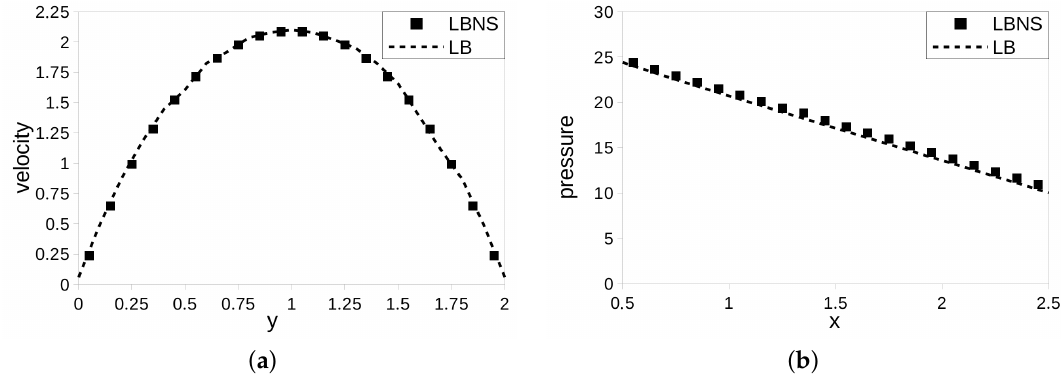
Figure 6. Pressure and velocity profile in channel flow for LB and LBNS. ( a ) Velocity profile at cross-section ( 1.5, y ,1.0 ) , y ∈ [ 0.0,2.0 ] ; ( b ) Pressure profile along centerline of the channel ( x ,1.0, 1.0 ) , x ∈ [ 0.5,2.5 ] .